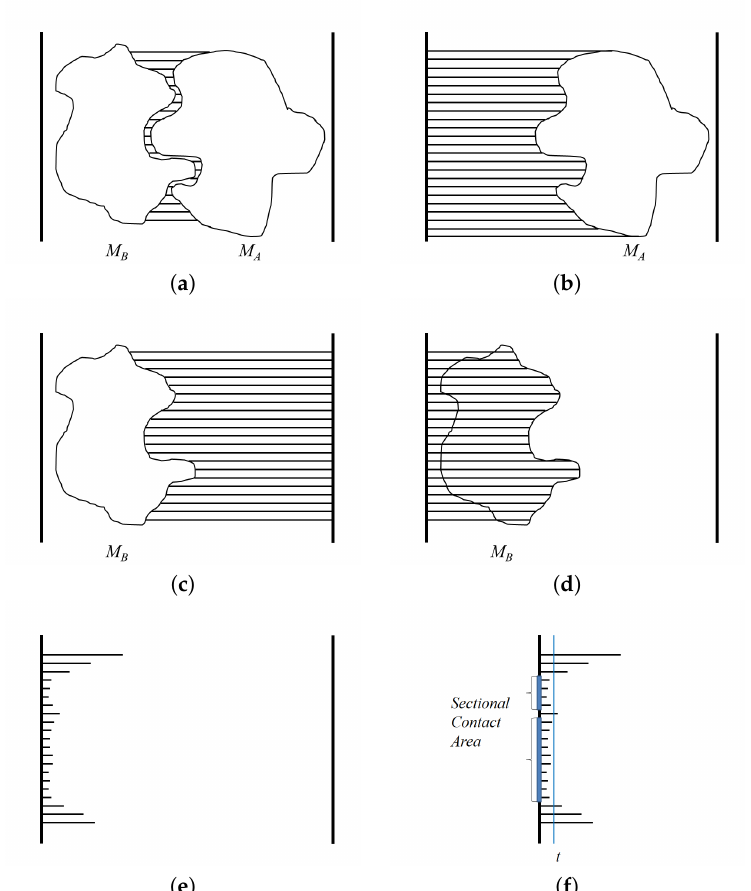
Figure 5. Computation of the distance and contact area between two molecules using depth buffer: ( a ) the distance between M A and M B ; ( b ) the depth values of M A from viewpoint (0,0, − ∞ ); ( c ) the depth values of M B from viewpoint (0,0, ∞ ); ( d ) the subtracted depth values of M B ; ( e ) the distance values between M A and M B ; and ( f ) the sectional contact